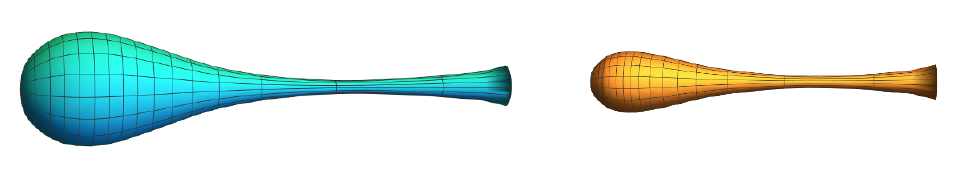
Figure 9 . Embedding in Euclidean space of the boundary (left) and the horizon (right) of a \bottle shaped" black hole in region D4 with (cid:22) = 3 : 8, (cid:23) = 3 : 895, close to the D2 border at (cid:23) = 2